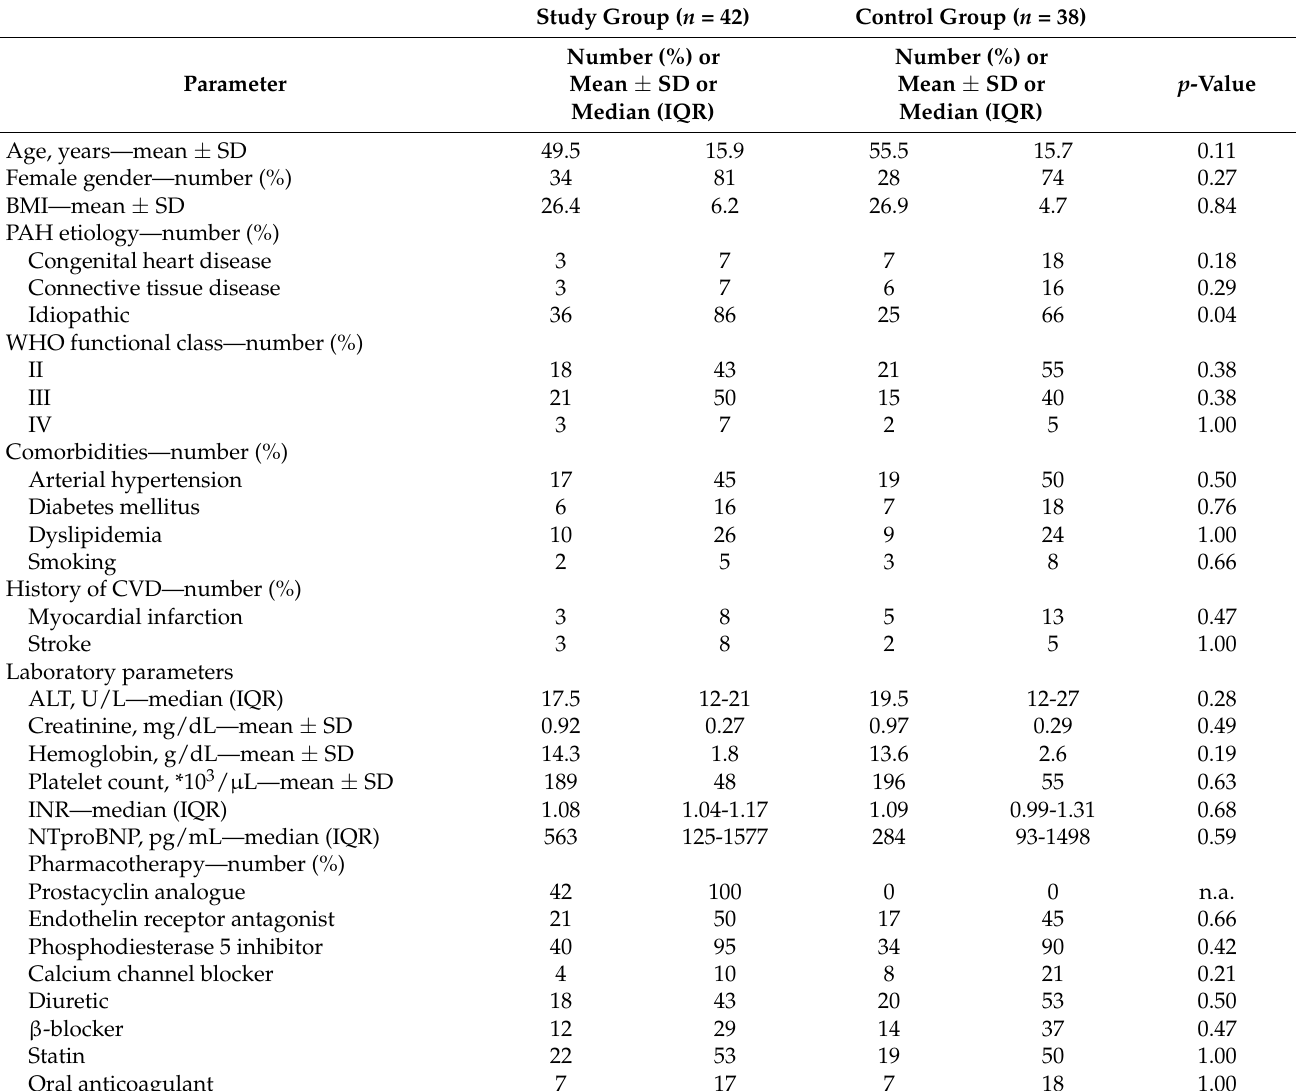
Table 2. Patient